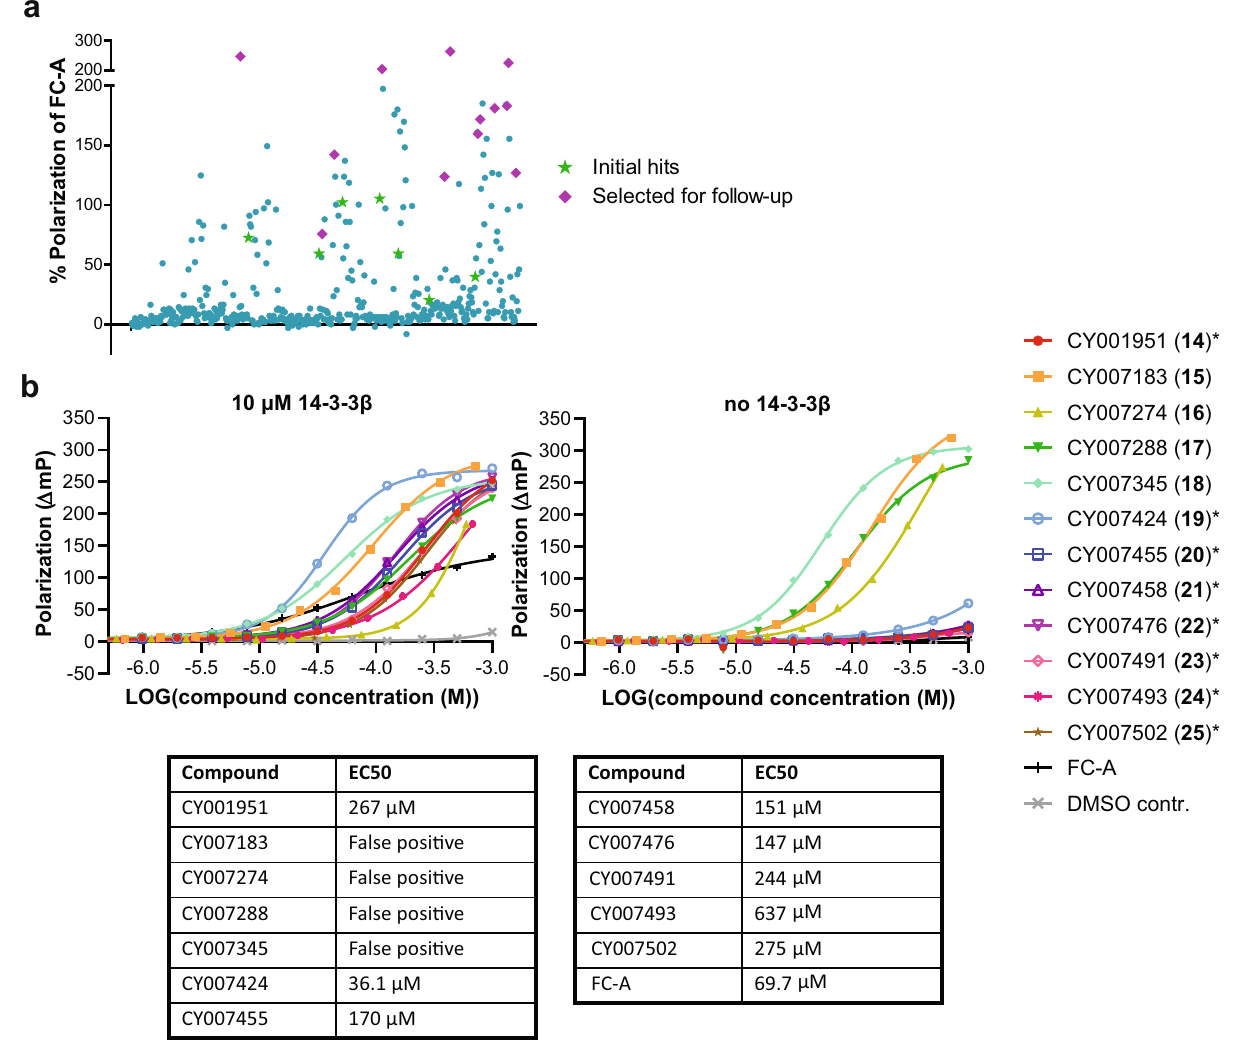
Fig. 2 Screening results of the hit validation library that consisted of resynthesized primary hit compounds and newly designed macrocycles to explore structure-activity relationships. a HTS FP of all 480 compounds. The samples contain 100 nM of FITC-CFTRpS753pS768 peptide, 10 μ M 14-3-3 β , and approximately 125 μ M compound, dependent on the compound stock concentration. The positive control was FC-A (100 µ M) and negative control was DMSO. Green stars are the initial hit compounds from previous library and the purple diamonds are selected for the follow-up dose-response assay. b Dose – response FP follow-up assay of the selected hit compounds stabilizing the interaction between 14-3-3 β (10 μ M) and labeled CFTRpS753pS768 (100 nM) peptide. Background polarization was subtracted from all values, n = 3 technical replicates. Compounds selected for further analysis are indicated with an asterisk. Source data are provided as a Source Data fi